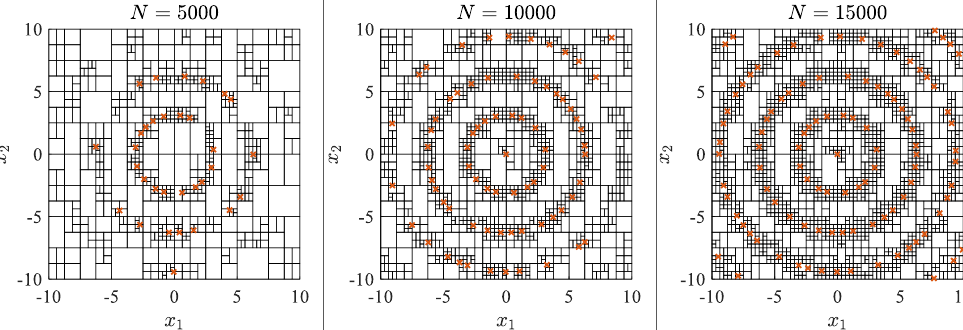
Figure 9. The partition states (a square indicates a region) and the obtained optima (the red crosses) as the total budget size N increases for the Schaffer’s function minimization problem.